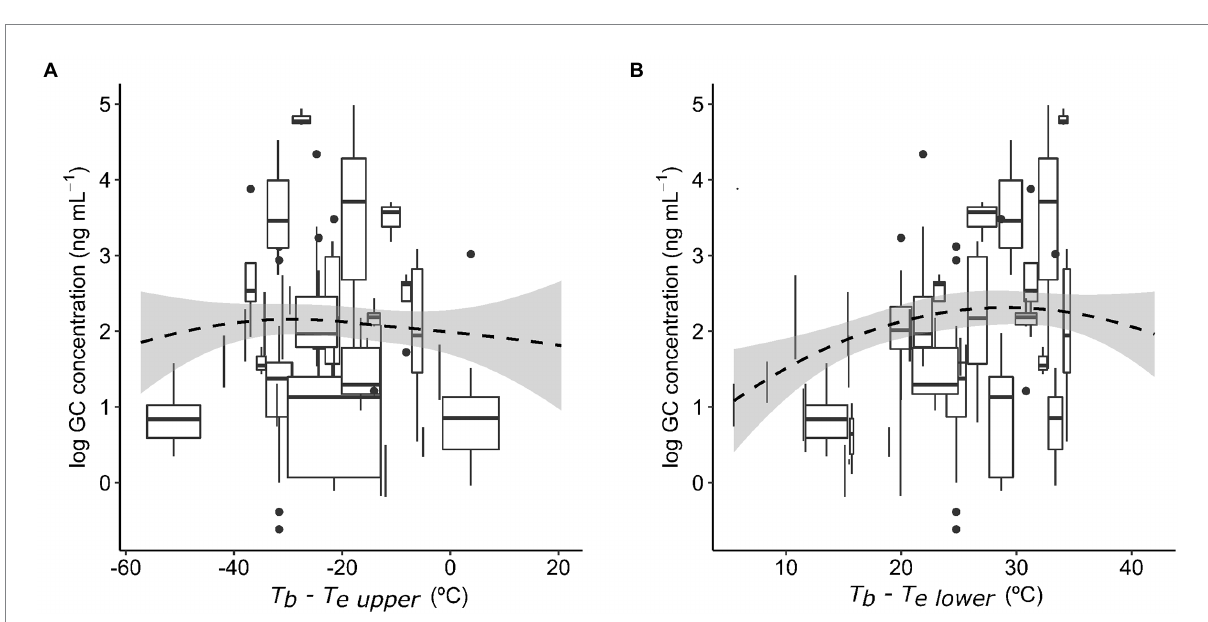
Bold denotes significant relationships. *Random